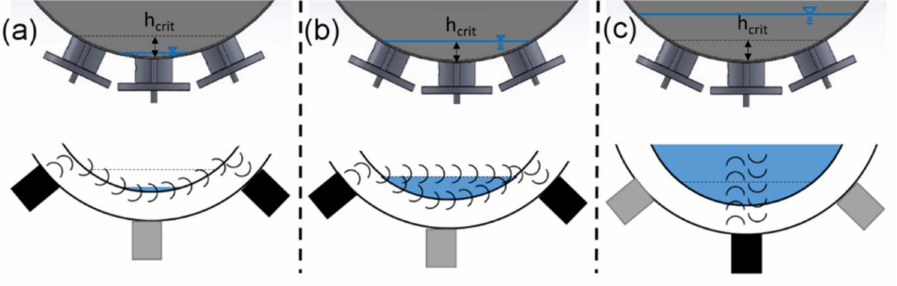
Figure 2. Schematic ultrasound sensor setup. Active transducers are highlighted in black. ( a ) Filling level below the critical level (hcrit): transmission measurement with SAW detection in pitch-catch mode only (black transducers). ( b ) Filling level at the critical level (hcrit): transmission measurement with SAW (steel–water surface) and with longitudinal wave (water) detection in pitch-catch mode. ( c ) Filling level above the critical level: reflection measurement with longitudinal waves for TOF determination in pulse-echo